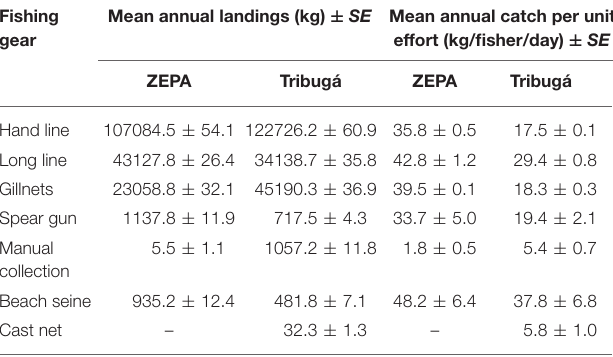
TABLE 1 | Fishing gears used in Northern Chocó region between 2010 and 2013, showing mean weight ± standard error of annual catch and annual mean catch per unit effort.